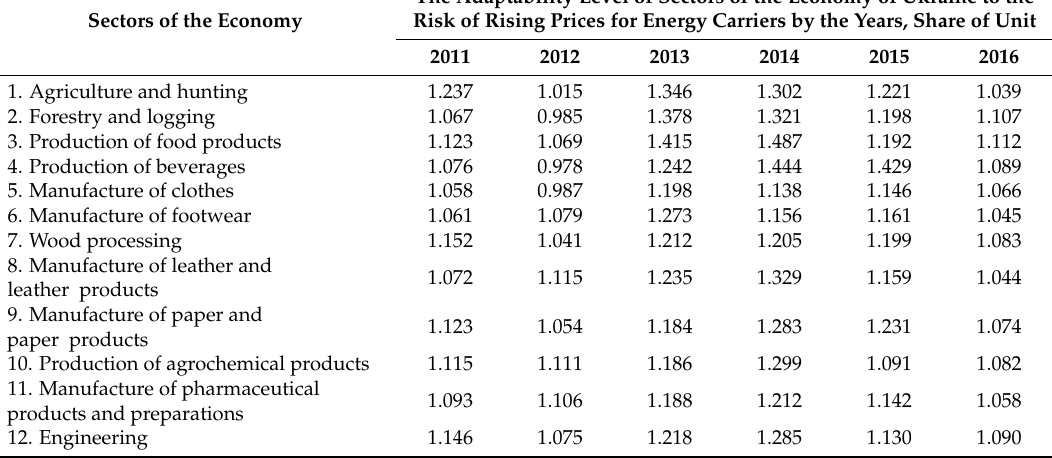
Table 6. The level of adaptability of sectors of the Ukrainian economy to the rise of prices for energy carriers (2011–2016) 1 .